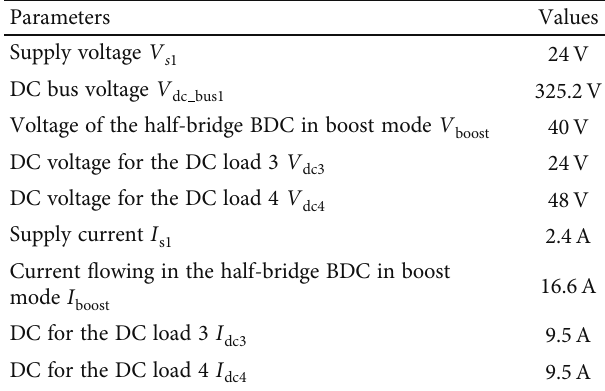
Figure 10: (a) DC supply current I V of the PV system-based DC microgrid operated with half-bridge BDC in boost mode. dc4